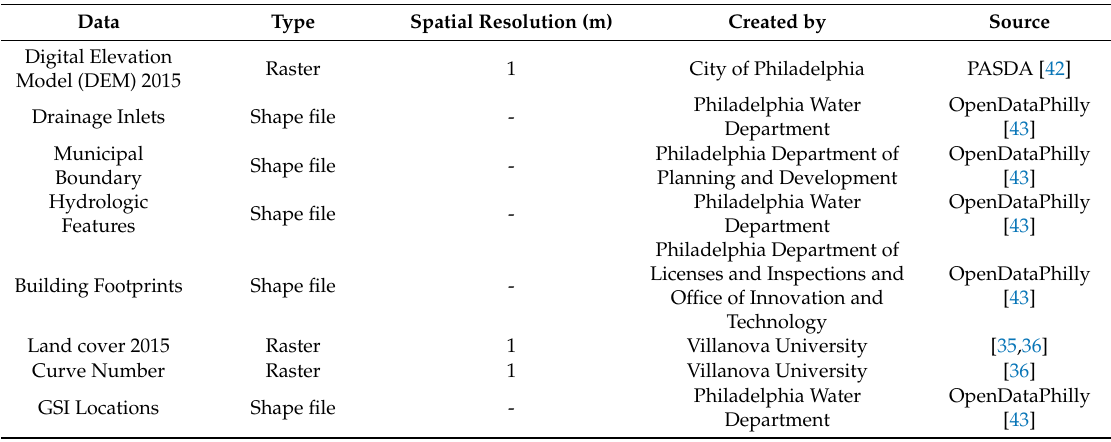
Table 2. Summary of study